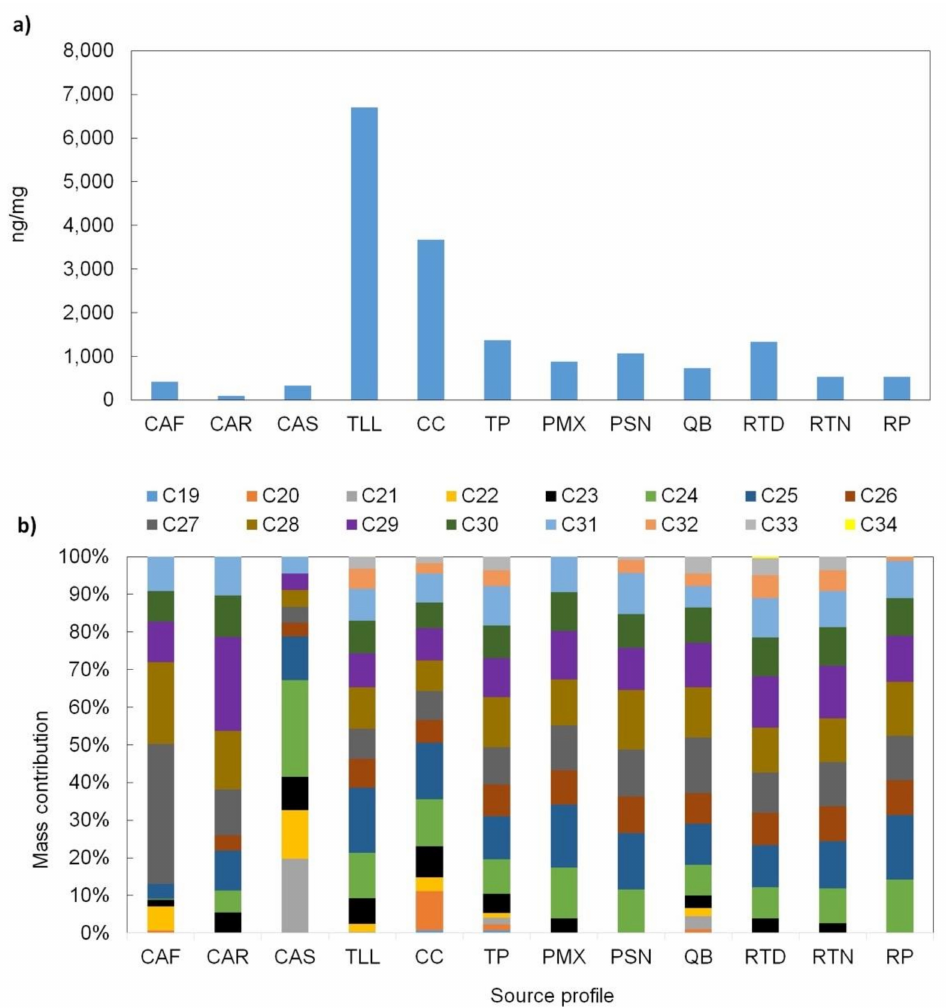
Figure 5. ( a ) n -alkanes total concentration and ( b ) mass contribution of individual n -alkanes to the total n -alkanes EOM for each source profile. Definition of source profile codes are presented in Table